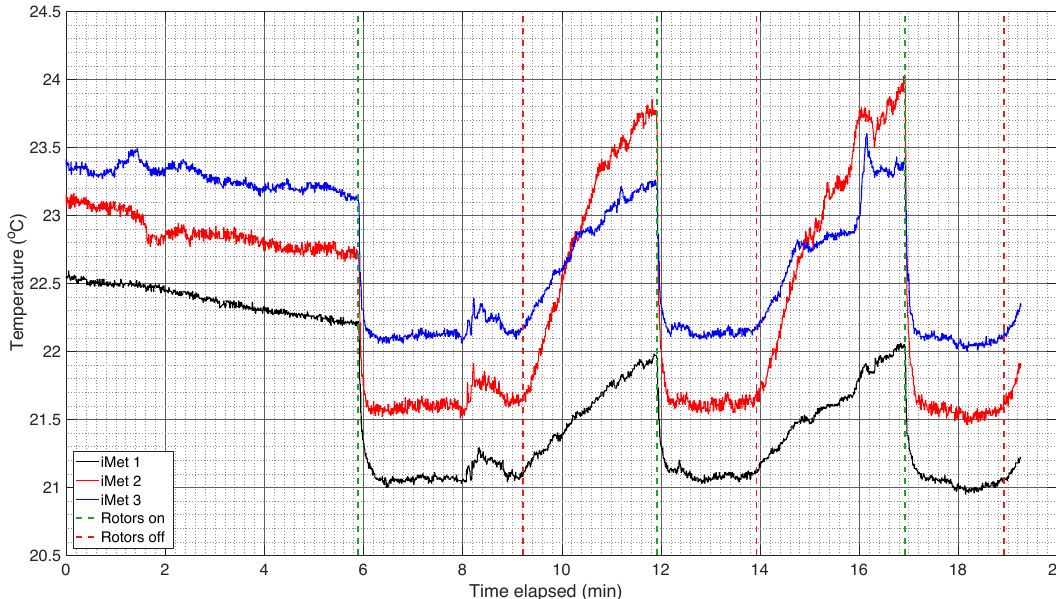
Figure 3. Time series of the uncalibrated iMet temperature sensors sampling at 10Hz relative to the times the fan was switched on (green dashed line) and off (red dashed